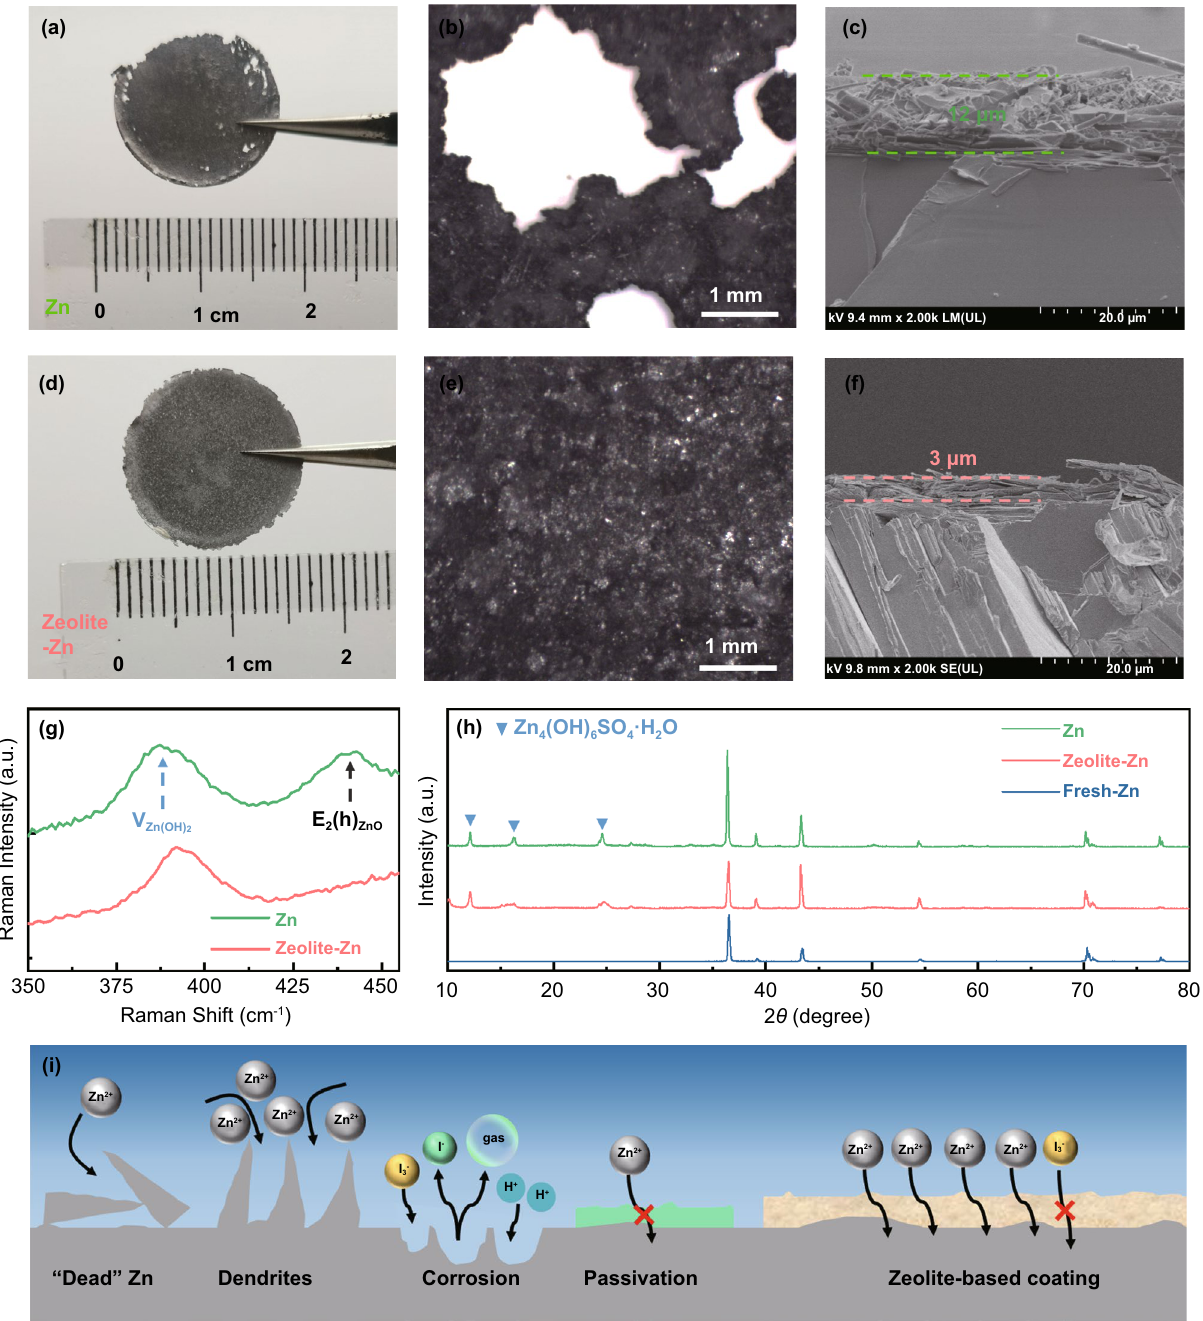
Fig. 3 a, d Photographs, b, e optical micrographs, c, f SEM images, g Raman spectra and h XRD patterns of the bare-Zn and Zeolite-Zn elec- trodes after working for 313 h and 500 h at 2.5 mA cm −2 and 2.5 mAh cm −2 in the symmetric cells, respectively. i Schematical illustration show- ing the protecting effects of the zeolite-based